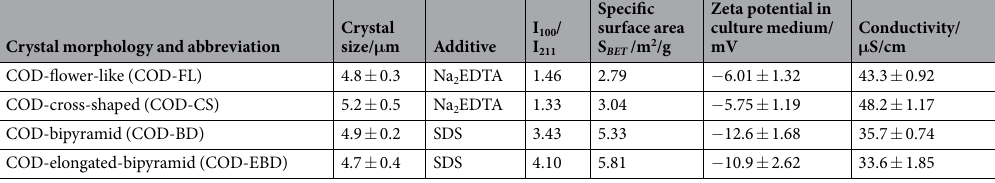
Table 1. Characterization of the physical and chemical properties of COD crystals with various